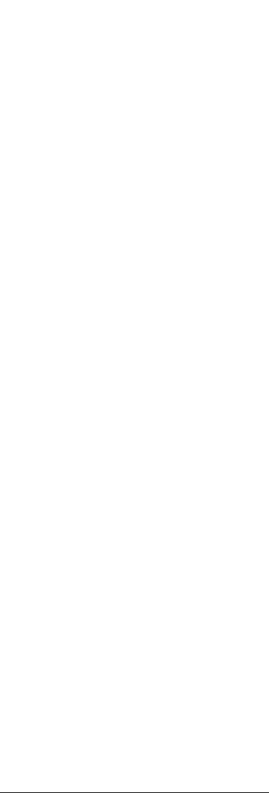
van der Gaag W H et al . BJGP Open 2017; DOI: